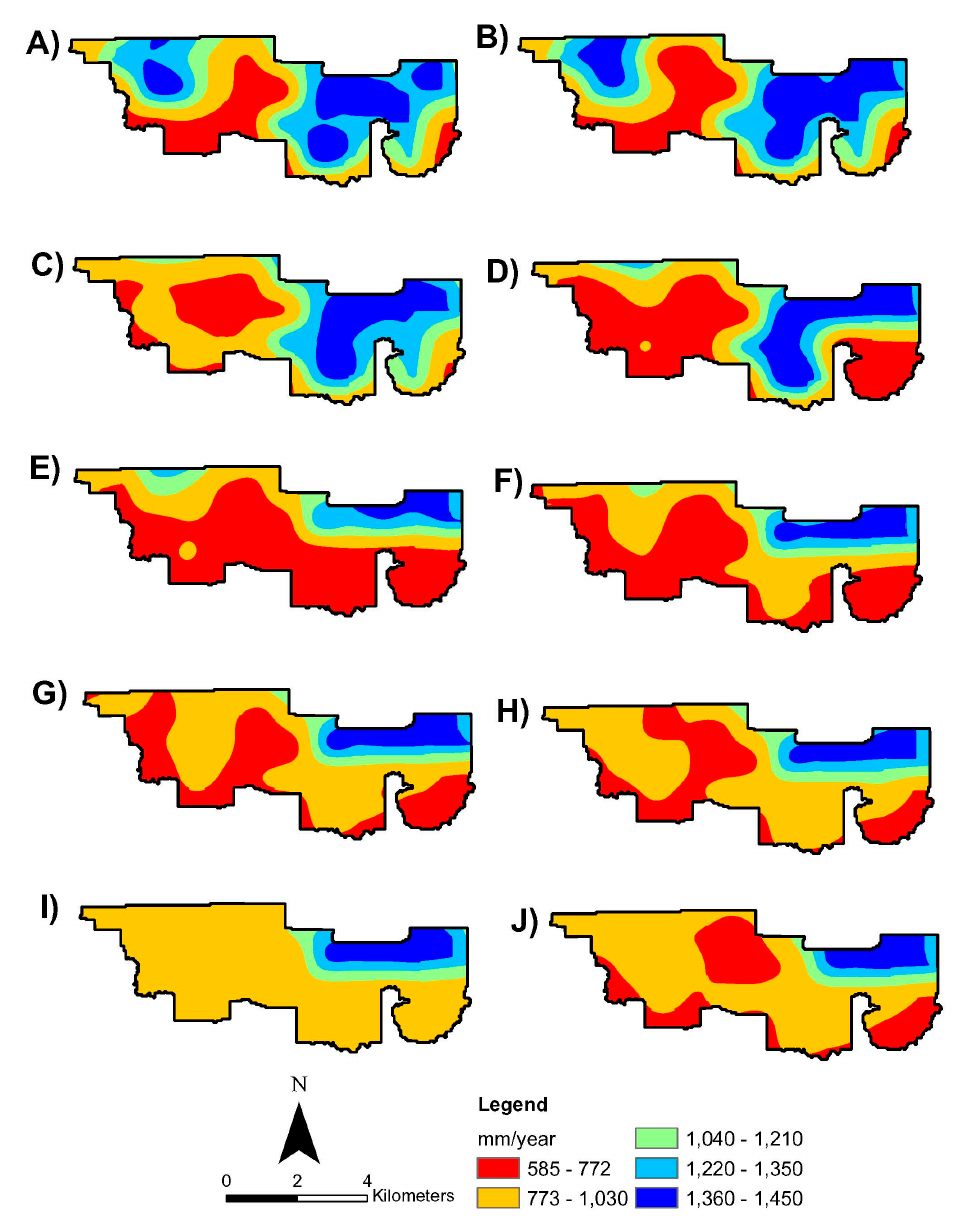
Figure 3. Maps of ET rates in mm/year across the HID in ( A ) 2000; ( B ) 2001; ( C ) 2003; ( D ) 2004; ( E ) 2005; ( F ) 2009; ( G ) 2010; ( H ) 2011; ( I ) 2013; ( J ) 2014. (Adapted from [42]).